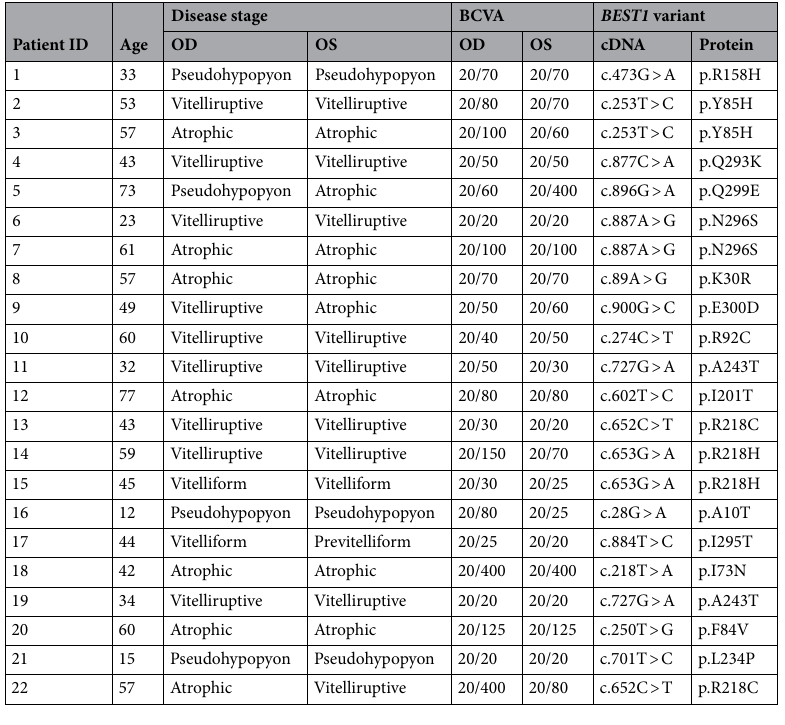
Table 1. Demographical, clinical, and genetic sequencing information of the patient cohort analyzed in the study. BCVA Best-corrected visual